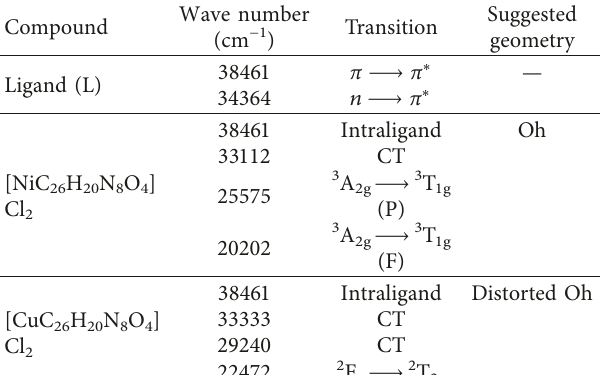
Table 4: Electronic spectra of the complexes.